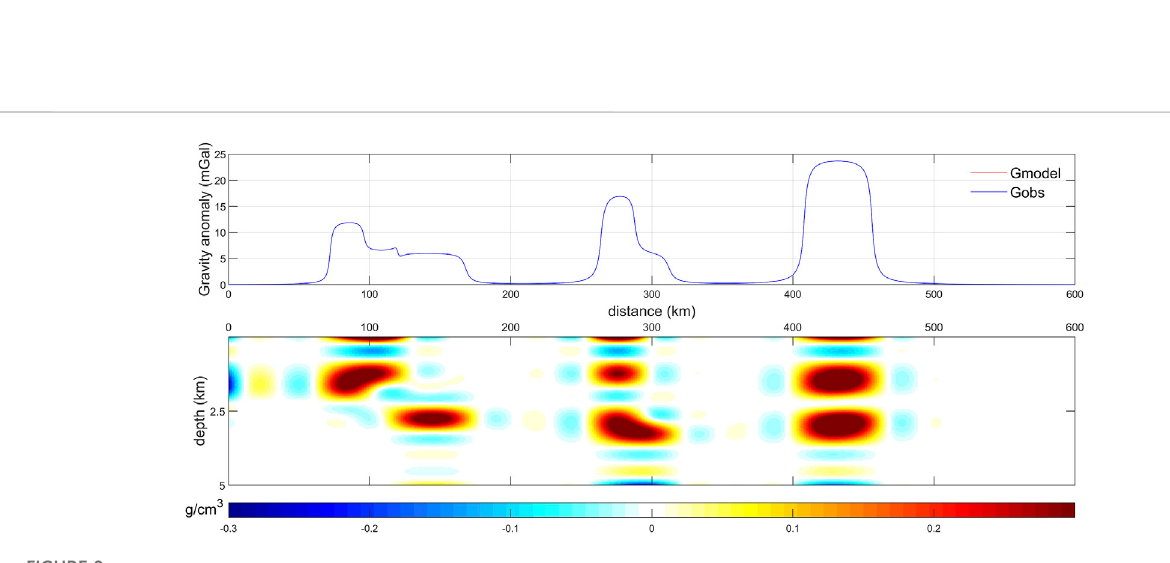
FIGURE 9 Inverted pro fi le density distribution from the gravity anomaly. Gobs: inputted gravity